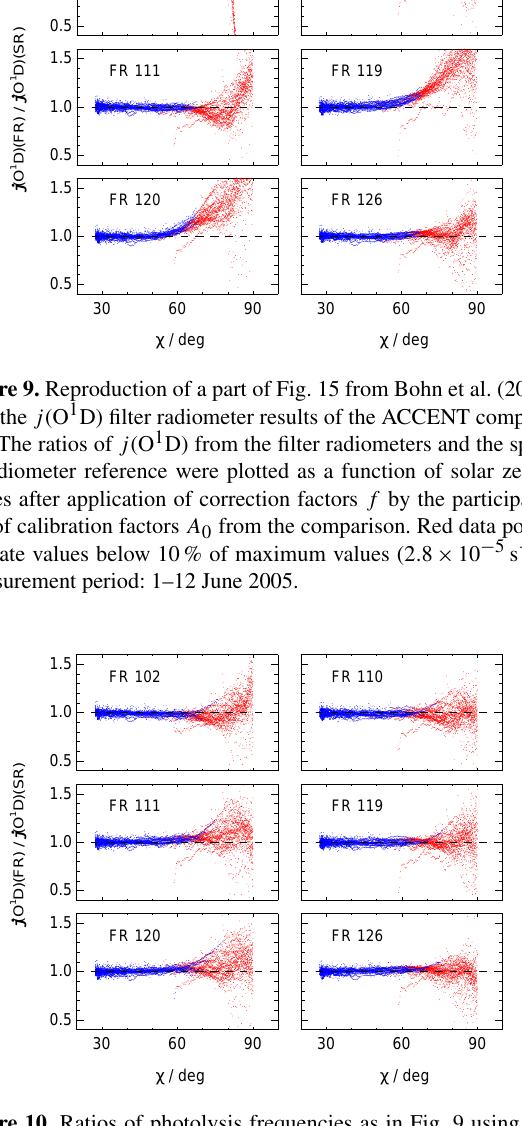
Figure 10. Ratios of photolysis frequencies as in Fig. 9 using up- dated correction factors f based on spectral sensitivities of the original instruments with old interference filters determined in this